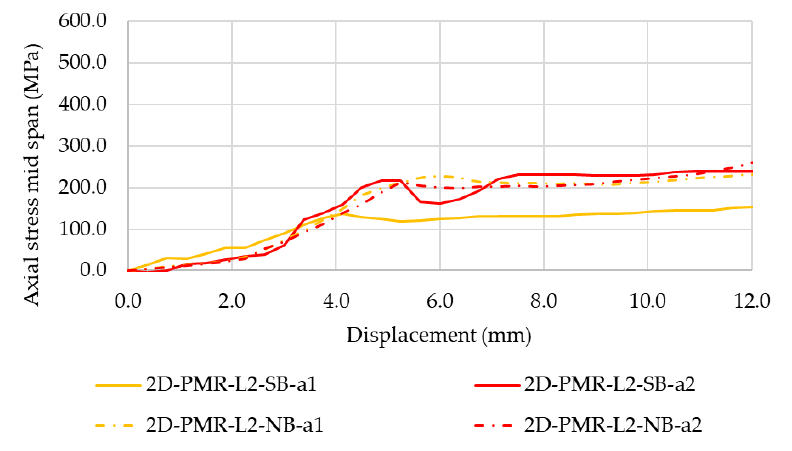
Figure 16. Axial stress at the steel connectors mid-span versus the plate’s vertical displacement diagram for the 2D-PMR models of the two-level strengthening scheme: bond influence.